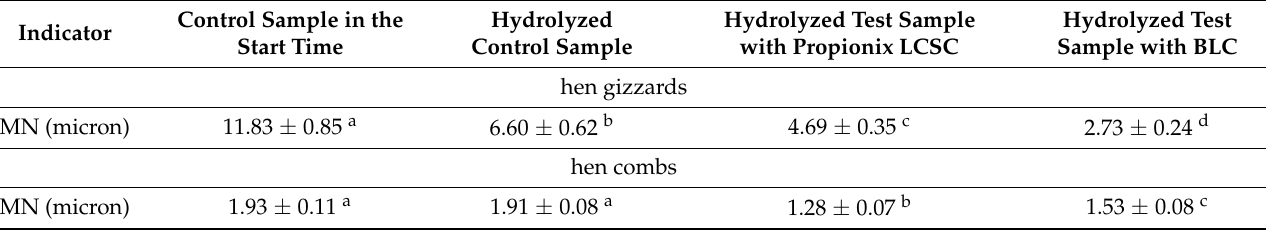
Table 2. Average hydrodynamic diameter determined from the numerical particle size distribution in hydrolysates. Control Sample in Indicator